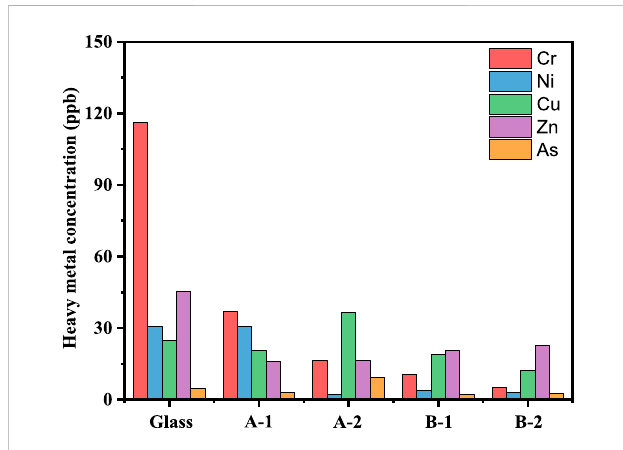
FIGURE 5 Leaching concentration ofCr,Ni, Cu, Znand As in different sample.